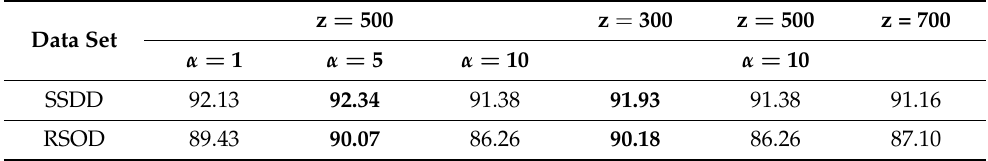
Table 5. Effects of different hyperparameter combinations on the absorption pruning